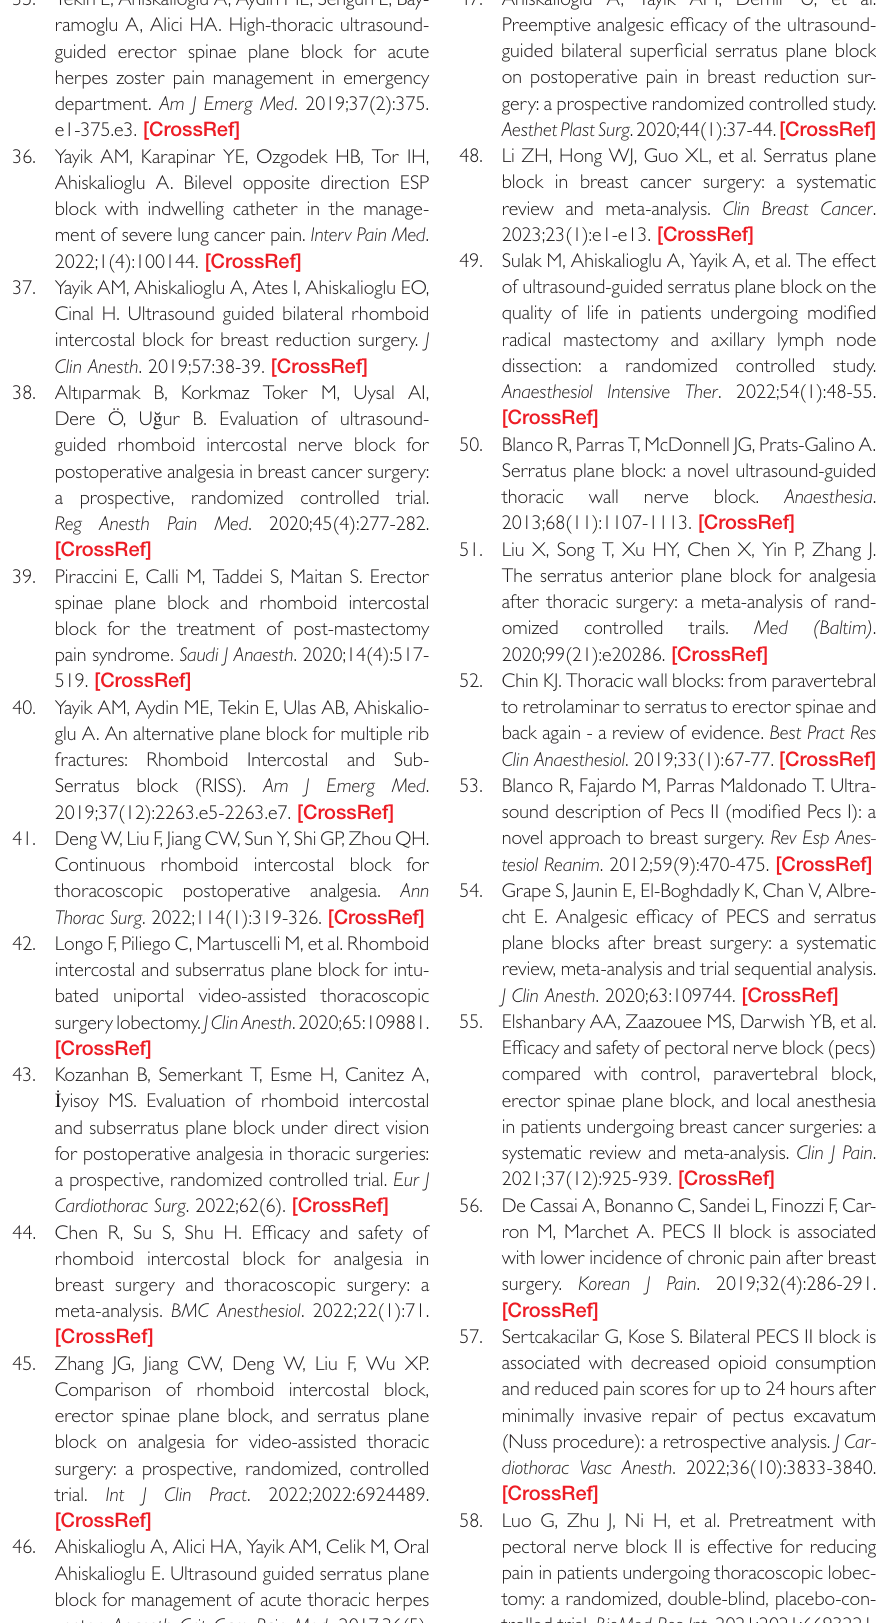
extremity surgery: erector spinae plane block. Min- erva Anestesiol . 2020;86(3):358-360.